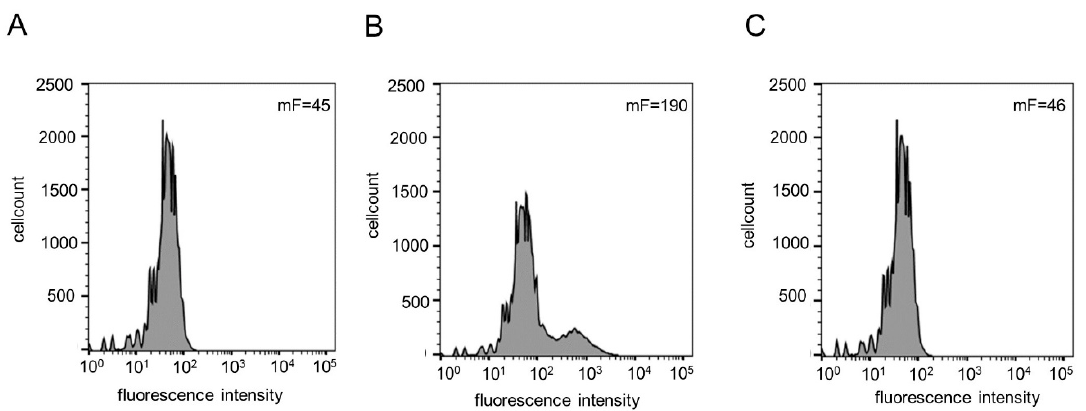
Figure 3. Flow cytometry analyses of immune-labeled E. coli F470 cells carrying pAIDAI rha -Hyal1. Analysis and determination of mean fluorescence intensity (mF) of cells without induction of Hyal1 expression (45) ( A ), induction of Hyal1 expression (190) ( B ) and cells with induced Hyal1 expression and proteinase K treatment prior to flow cytometry analysis (46) ( C ). After 16 h of cultivation cells were harvested and incubated with a primary monoclonal, anti-myc antibody and a secondary Dylight 633 -conjugated anti-IgG antiserum and analyzed after washing by flow cytometry.